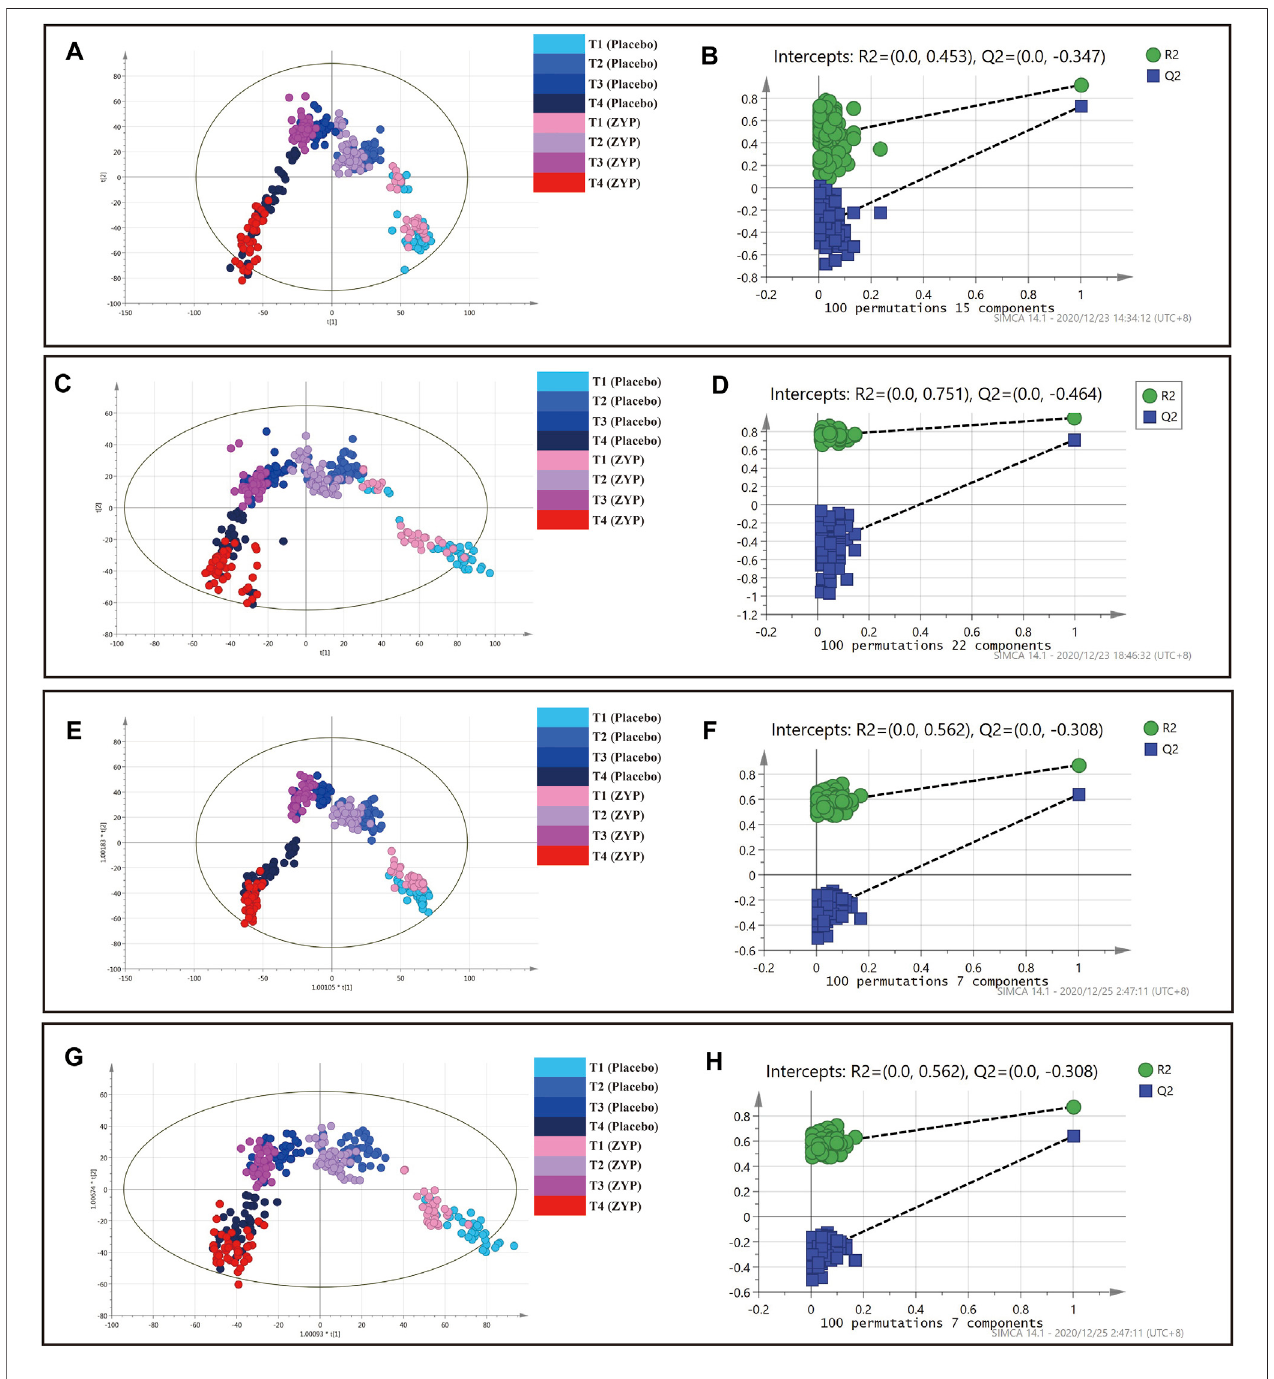
FIGURE3| PLS-DAandOPLS-DAanalysisonplasmasamplesinwholedataset. (A) PLS-DAanalysisinpositivemode. (B) PermutationtestofPLS-DAanalysisin positive mode. (C) PLS-DA analysis in negative mode. (D) Permutation test of PLS-DA analysis in negative mode. (E) OPLS-DA analysis in positive mode. (F) Permutation test of OPLS-DA analysis in positive mode. (G) OPLS-DA analysis in negative mode. (H) Permutation test of OPLS-DA analysis in negative mode. : T1 (Placebo), : T2 (Placebo), : T3 (Placebo), : T4 (Placebo), : T1 (ZYP), : T2 (ZYP), : T3 (ZYP), : T4 (ZYP).